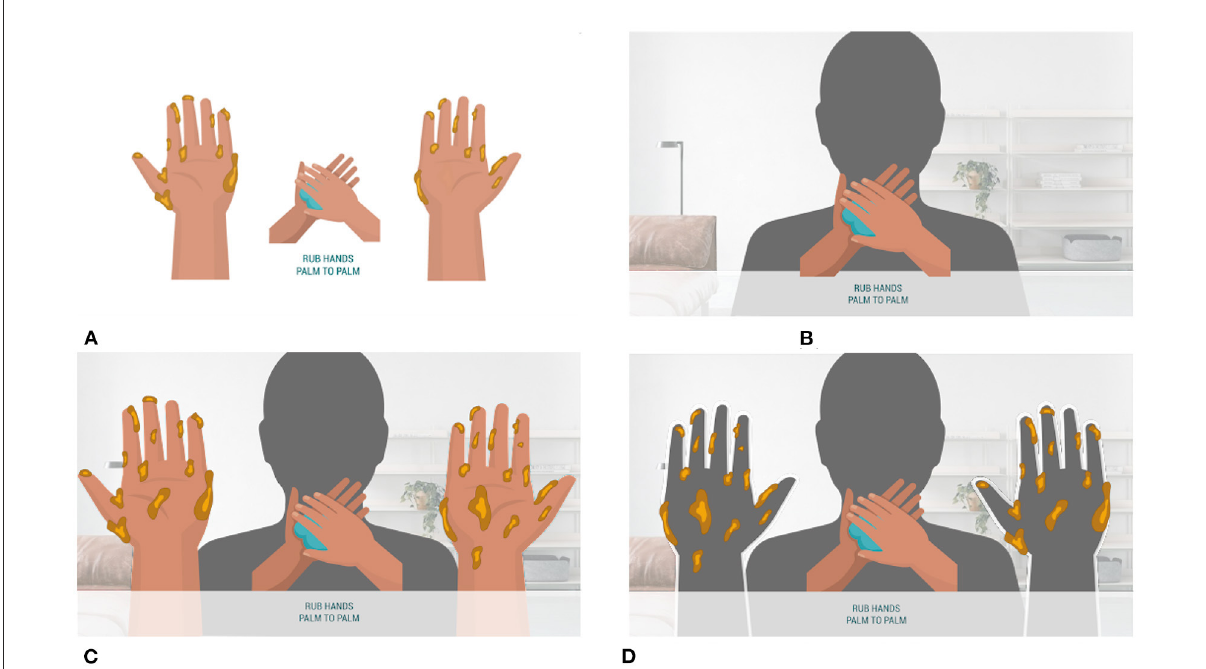
FIGURE1 The goal of study 1 was to investigate the effects of self-focused AR on behavioral intention and perception. (A) The reinforcement condition displayed a handwashing animation in addition to animation with germs disappearing from a pair of illustrated hands as the handwashing animation progressed. (B) The self-focused AR condition displayed the handwashing animation layered on top of the viewer’s reflection. (C) The avatar condition included an animation showing germs disappearing from a pair of illustrated hands layered on top, with the user’s reflection in the background. (D) In the self-focus AR x reinforcement condition, as the handwashing animation progressed, participants saw germs disappear from the reflection of their own hands.